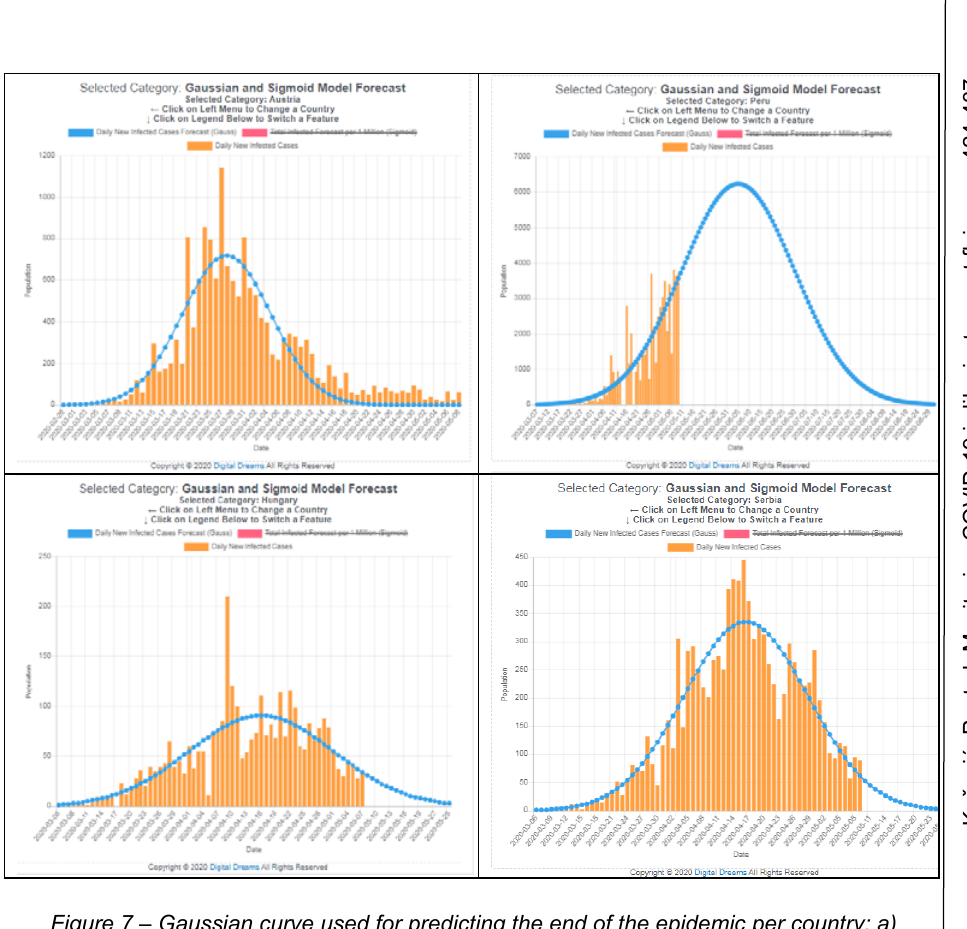
Figure 7 – Gaussian curve used for predicting the end of the epidemic per country: